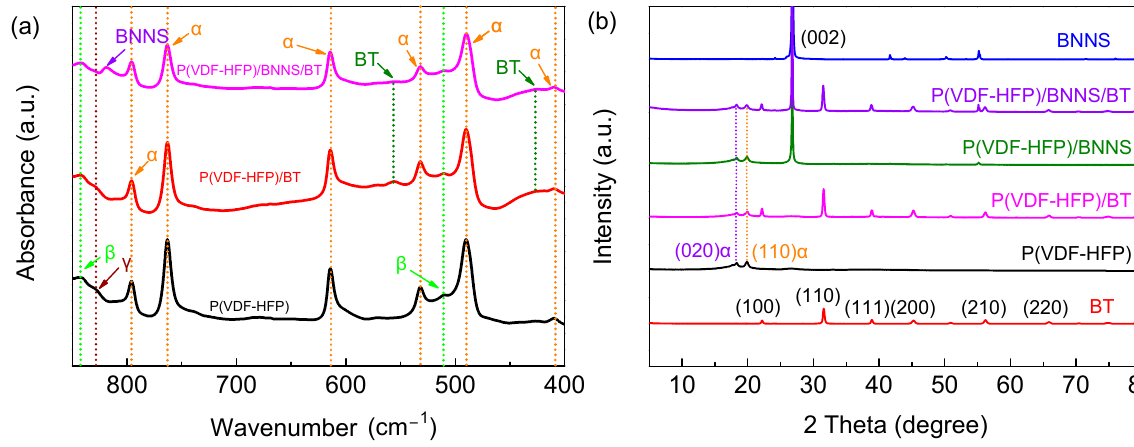
Figure 2. ( a ) FT-IR spectra of pure P(VDF-HFP), P(VDF-HFP)/BT, and P(VDF-HFP)/BNNS/BT. ( b ) XRD patterns of the BNNS, BT, pure P(VDF-HFP), P(VDF-HFP)/BNNS, P(VDF-HFP)/BT, and P(VDF-HFP)/BNNS/BT.